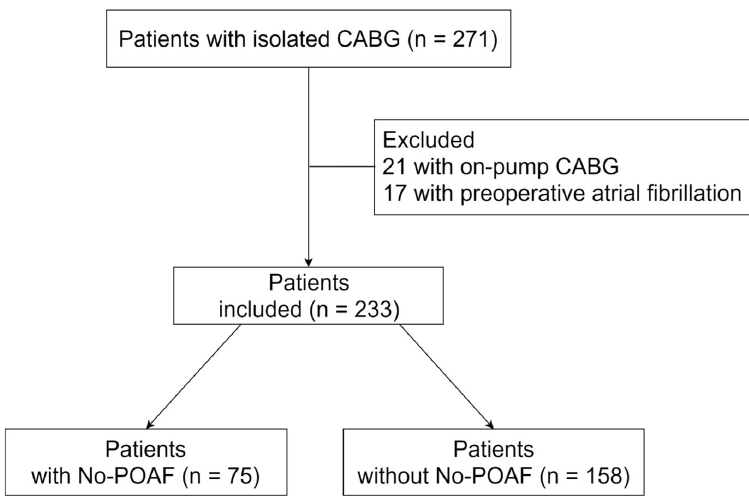
Fig. 1 - Study profile. CABG=coronary artery bypass grafting; No-POAF=new-onset postoperative atrial